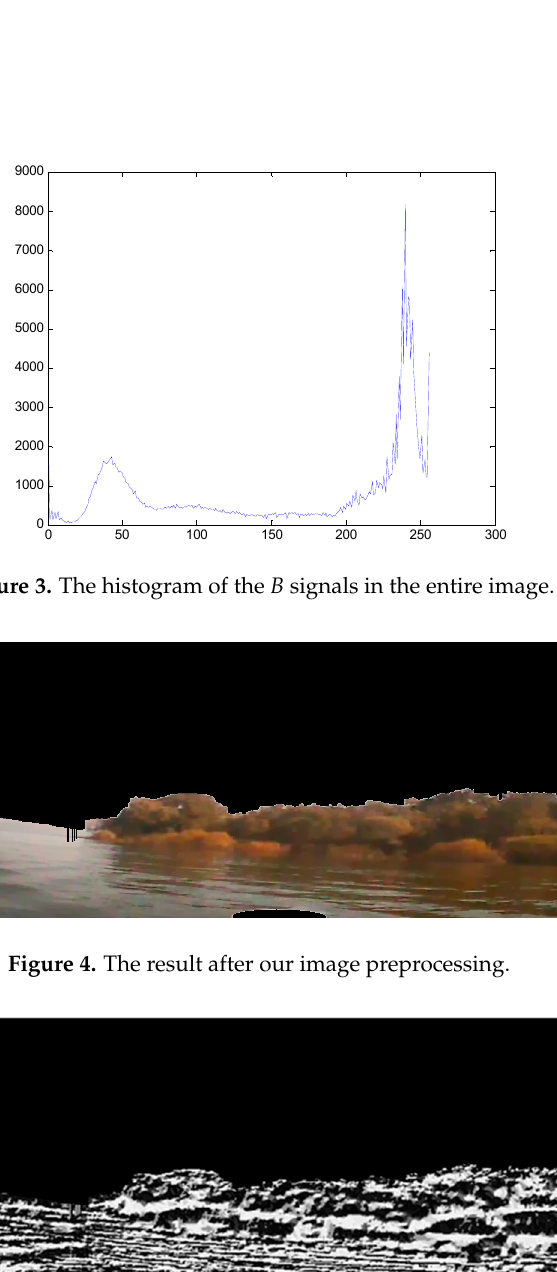
Figure 1. The image before structure extraction. Figure 2. The image after structure extraction. Then, in order to reduce the processing time and to improve the real-time ability of our method, it is necessary to segment the background (i.e., sky in our sample image) which almost has no textures